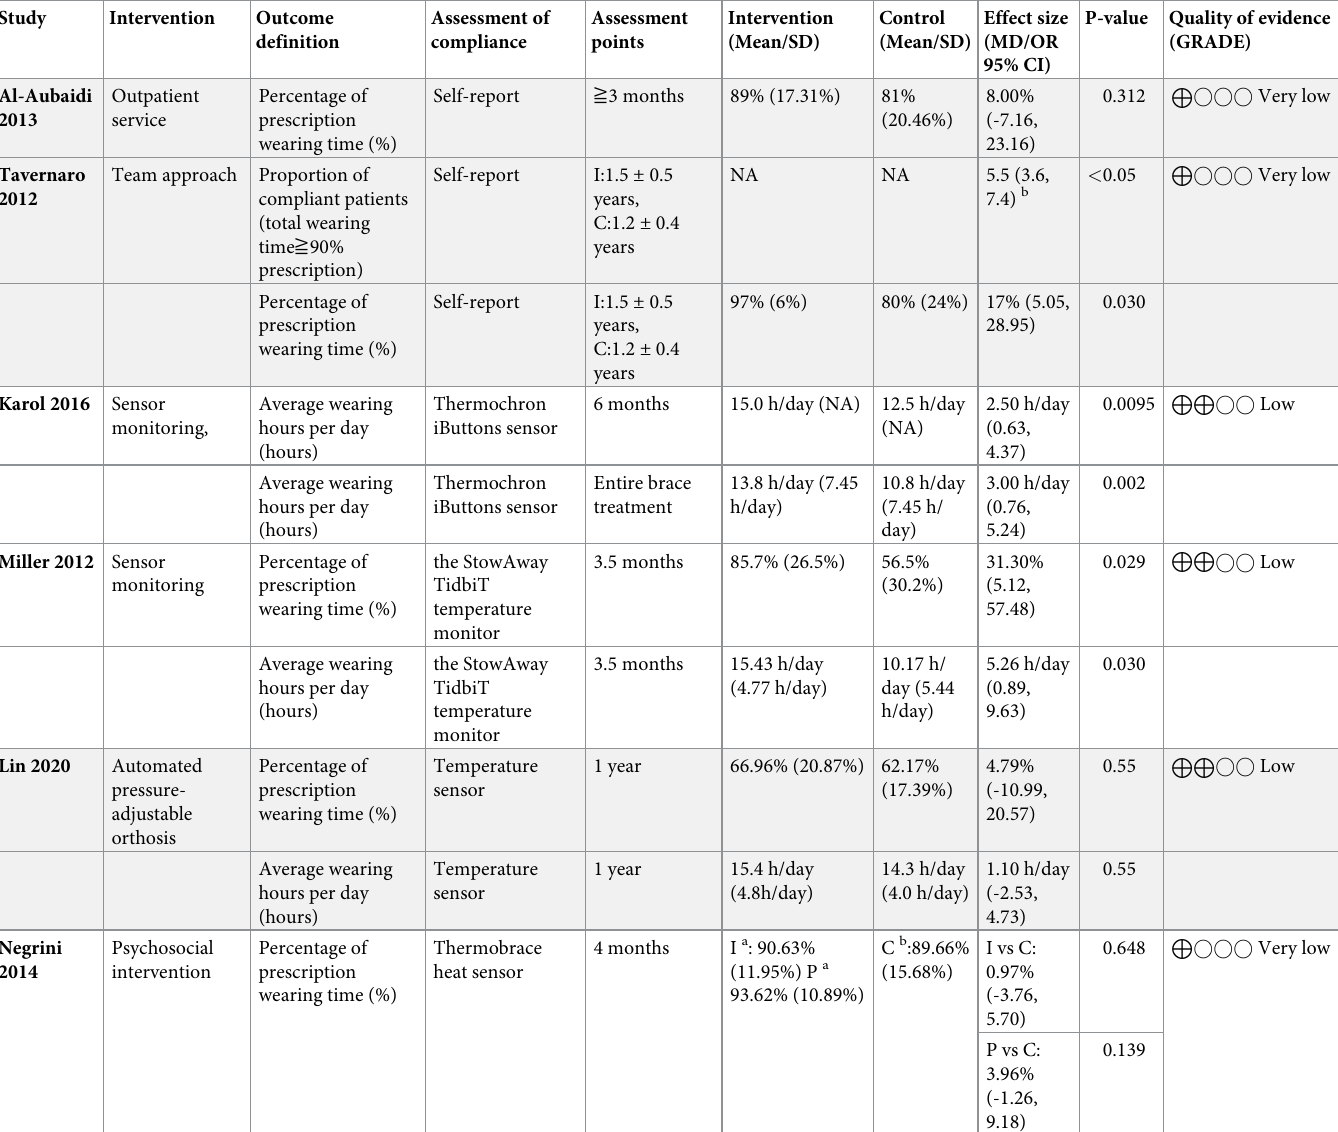
Table 2. Intervention effect on bracing